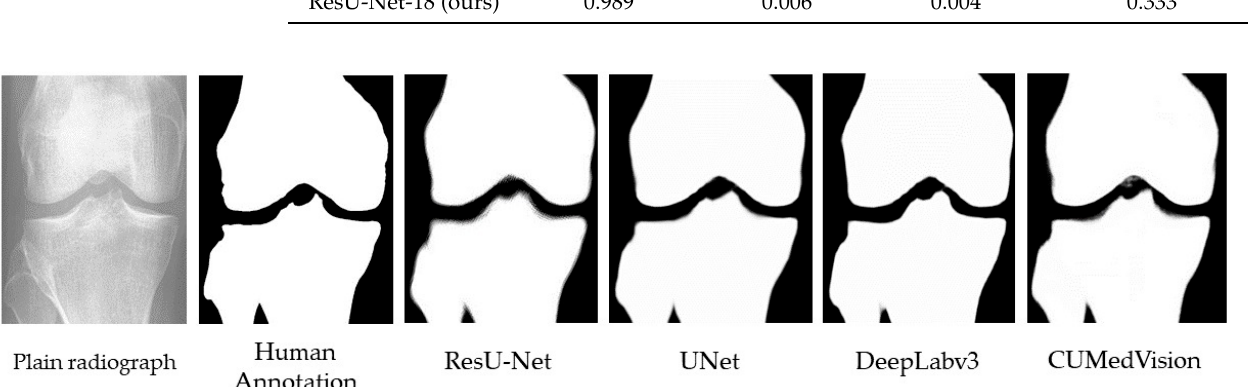
Figure 3. Comparison of masks produced by different semantic segmentation network architectures. Table 1. Segmentation performance of different deep learning models.